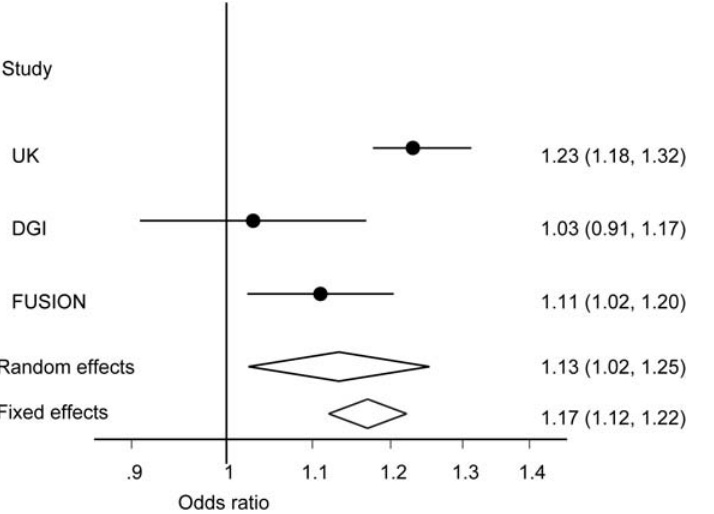
Figure 1. Meta-analysis of the FTOrs8050136 variant in terms of its association with type 2 diabetes across three GWA investigations. Each investigation is shown by the point estimate of the odds ratio and 95% confidence intervals. Also shown is the diamond of the summary effect by fixed and random effects calculations.